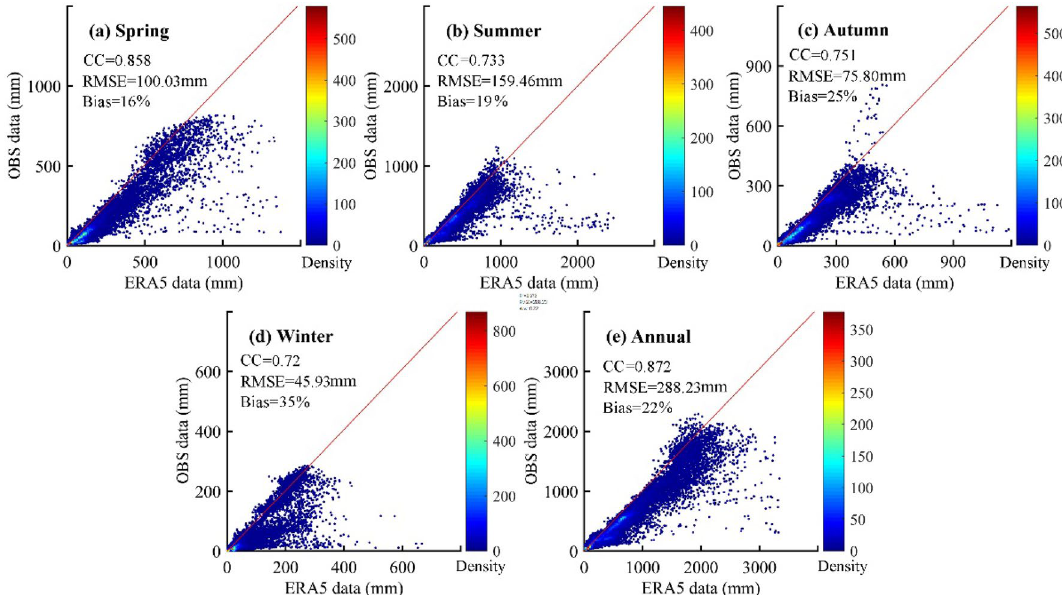
Figure 3. Seasonal ( a – d ) and annual ( e ) density scatter plots of observation (OBS) and ERA5 precipitation data in China from 1979 to 2018. The 1:1 line of perfect agreement (red line) and the colour represents the density of the grids. Note: correlation coefficient (CC), root-mean square error (RMSE), and relative bias a relatively higher error than that in other seasons. In general, the seasonal-scale precipitation data of the ERA5 has a good linear relationship with the observation, with slight overestimation in different seasons but with very small errors and high overall accuracy. To better understand the differences between the zones, Table 1 lists the quantiles (5%, 50% and 95%) of statistical indicators (CC, RMSE, and Bias) at a grid scale in the seven study zones for the seasonal ERA5 pre- cipitation data against to the observation. It shows that almost all divisions have higher CC and lower RMSE in the spring than in the summer, except for the SE region. In addition, the Bias in the summer in all seven zones is lower compared to that in the other three seasons. This indicates that ERA5 can adequately determine extreme precipitation. The highest CC occurs in the ENW region, but the lowest RMSE and Bias are in the N and NE regions, respectively. This maybe relates to their lower elevation and temperate continental climate, and the fact that weather stations are also more abundant in these areas, providing more accurate station data. The Tibetan Plateau region has the largest deviation regardless of the season, which means that ERA5 reanalysis data are weak for monitoring precipitation in the Tibetan region, and special attention should be paid to this region when applying the data. Generally, ERA5 precipitation data has reliability and high precision in ENW, N, and NE zones for all seasons, while higher Bias and RMSE are located in Tibet (Table 1). At the same time, Tibet has the lowest CC in the summer and winter. (Fig. 4(1)–(5)) and Bias (Fig. 4(6)–(10)) between the ERA5 and observations data. It is evident from the annual scale that the correlation coefficients are higher in SE, N, and NE China than in the other regions, and the value